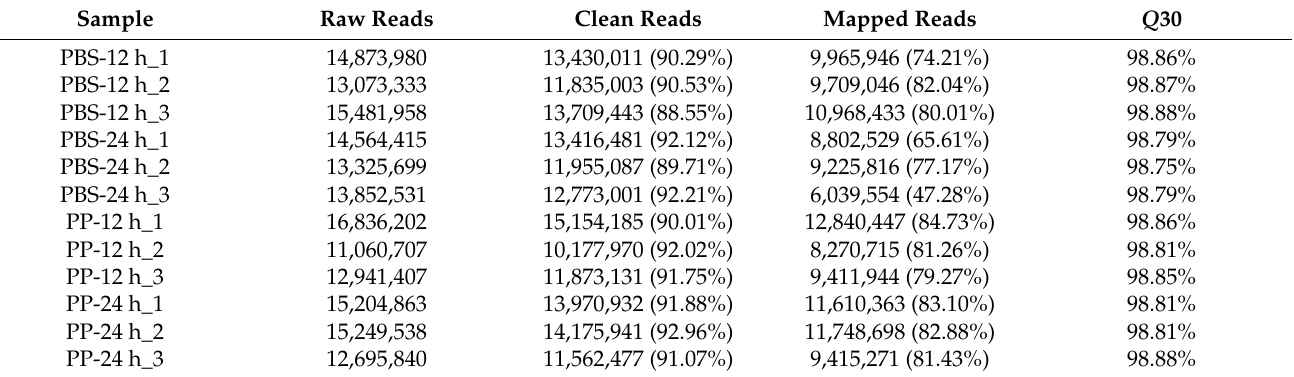
Table 1. Summary of the small RNA-seq dataset.